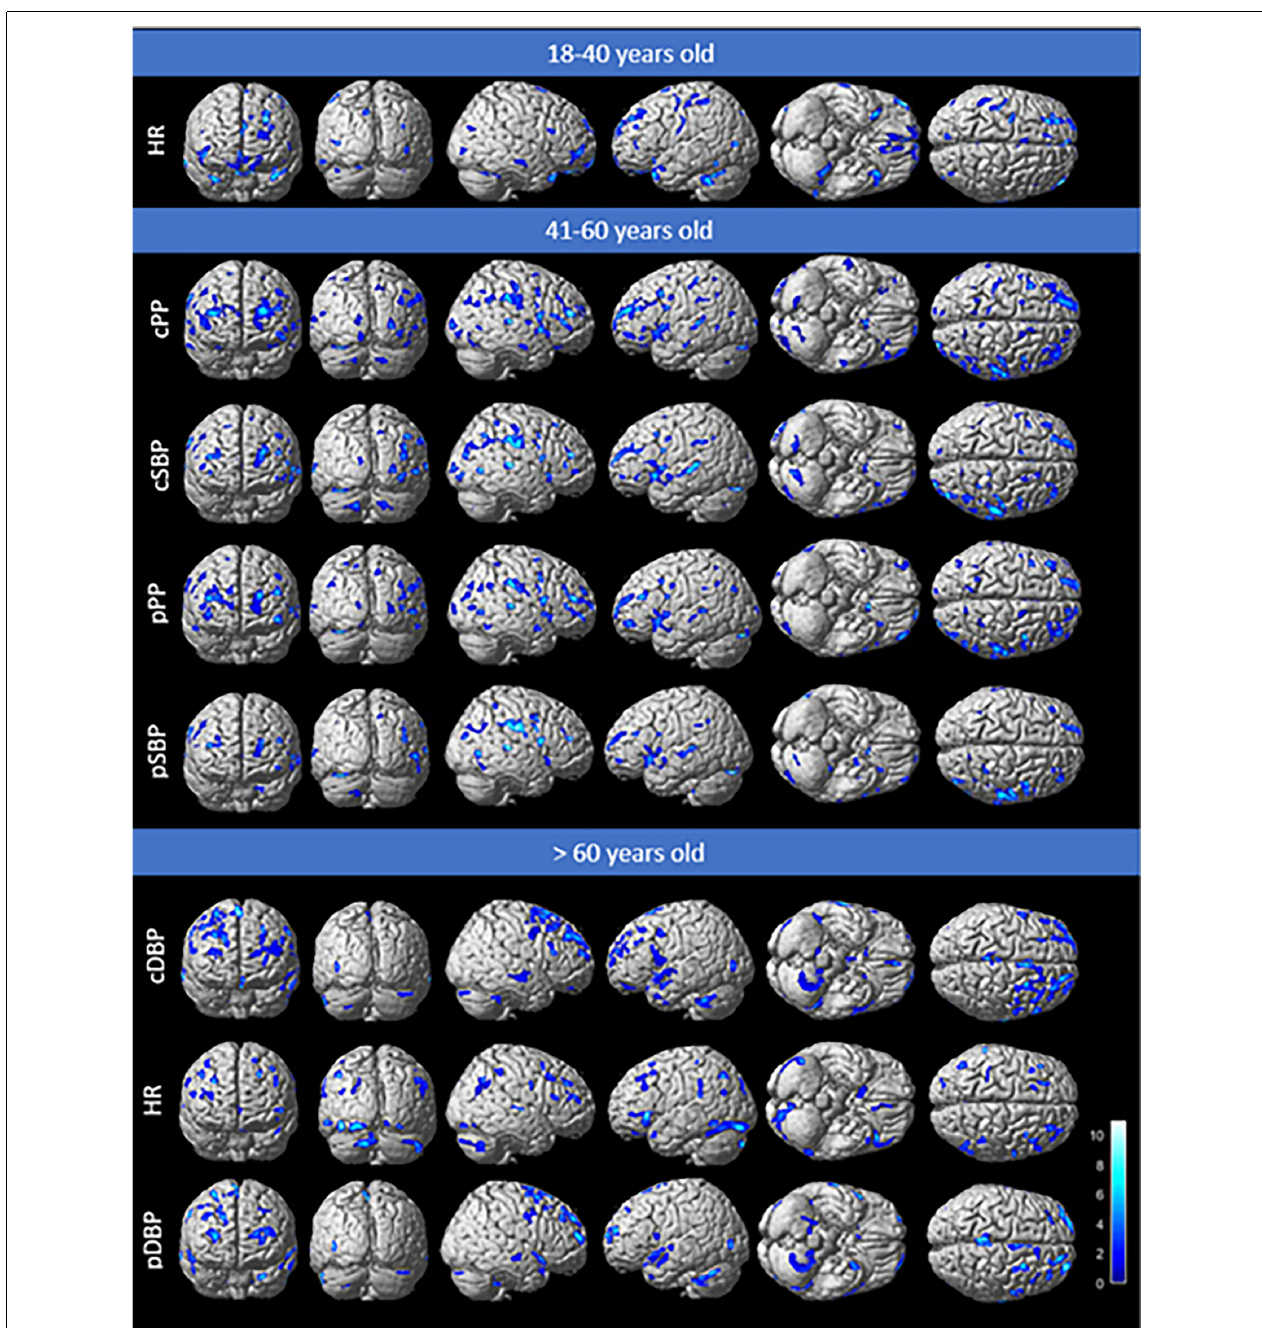
FIGURE 3 | Anatomical localization of clusters associated with parameters that have a significant impact on brain metabolism with negative associations ( p < 0.005, uncorrected), projected onto 3D volume-rendered images, spatially normalized, and smoothed into the standard SPM template. Parameters classified according to the cumulative significant cluster volumes for the three age